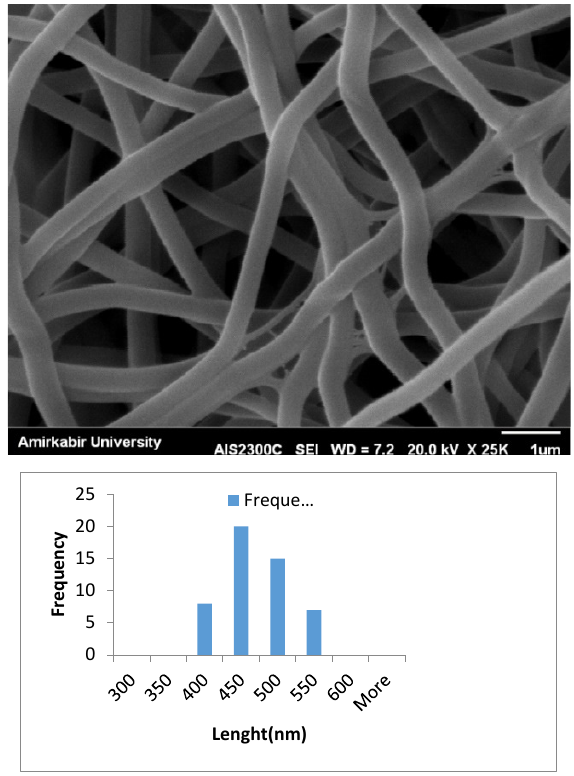
Fig. 5. SEM image of PVA/CS/ CeAlO electrospun nanofibers after cross-linking process, average nanofibers diameter (450 3